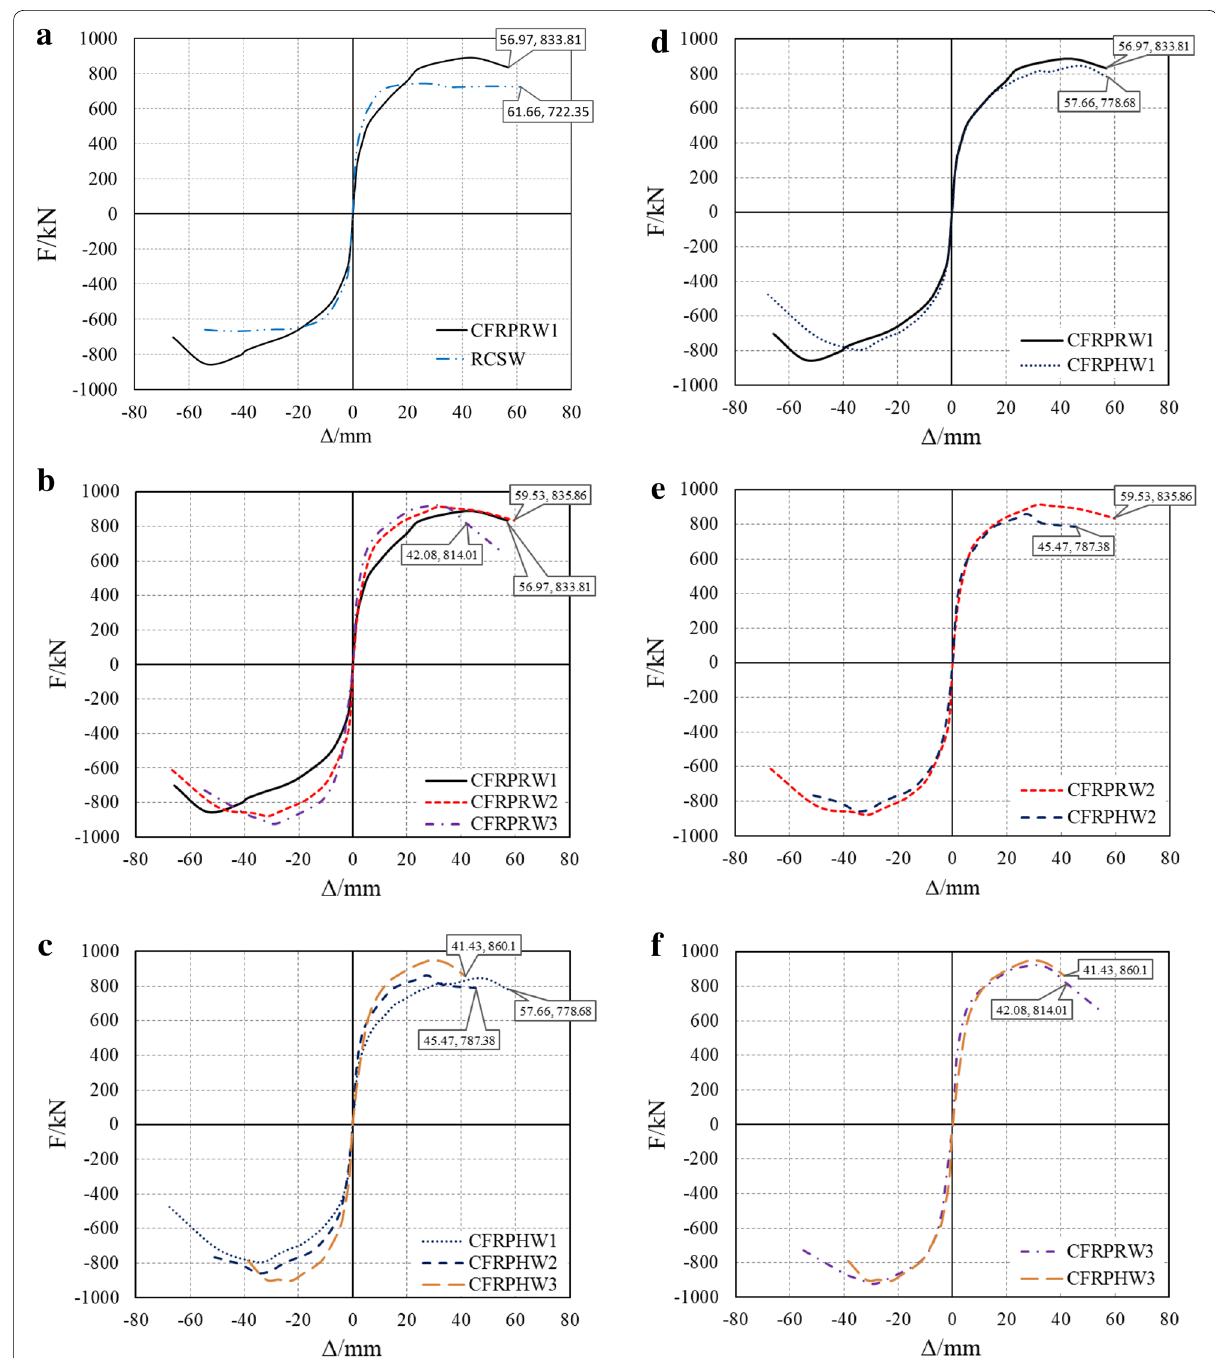
Fig. 9 Backbone curves. a comparison between ordinary and CFRP walls. b Specimens with rectangular stirrups at different axial compression ratios. c Specimens with circular stirrups at different axial compression ratios. d Specimens at 0.17 axial compression ratio. e Specimens at 0.26 axial compression ratio. f Specimens at 0.33 axial compression